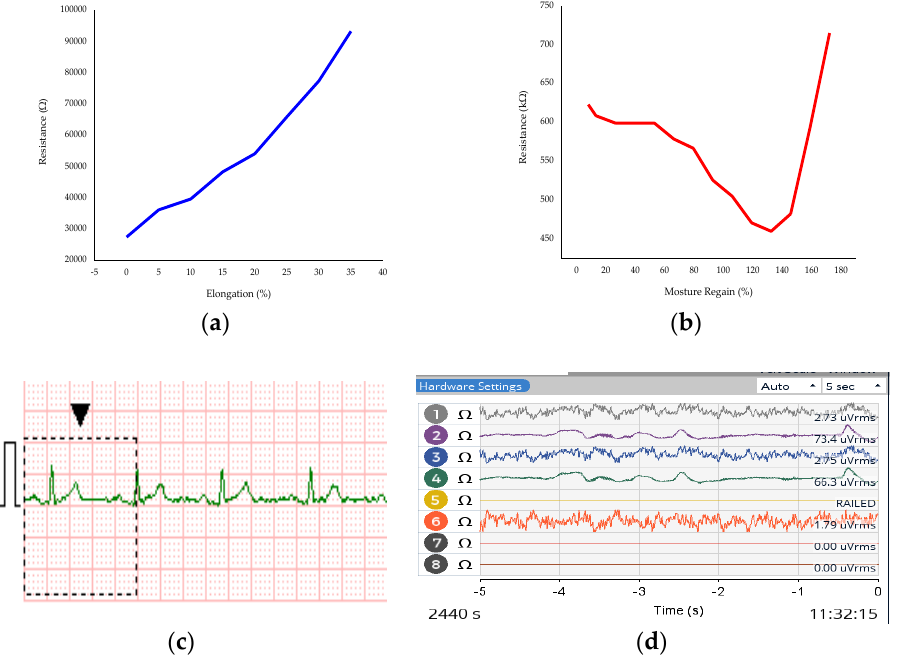
Figure 11. PEDOT:PSS / PDMS-b-PEO coated cotton electrodes for: ( a ) strain dynamic response at 0.67 cm / s rate of stretching for six seconds; ( b ) moisture dynamic response at1 ml / s rate of water spray for six seconds; ( c ) electrocardiography (ECG) signal using PC-80B; ( d ) electroencephalography (EEG) signal using OpenBCI board.